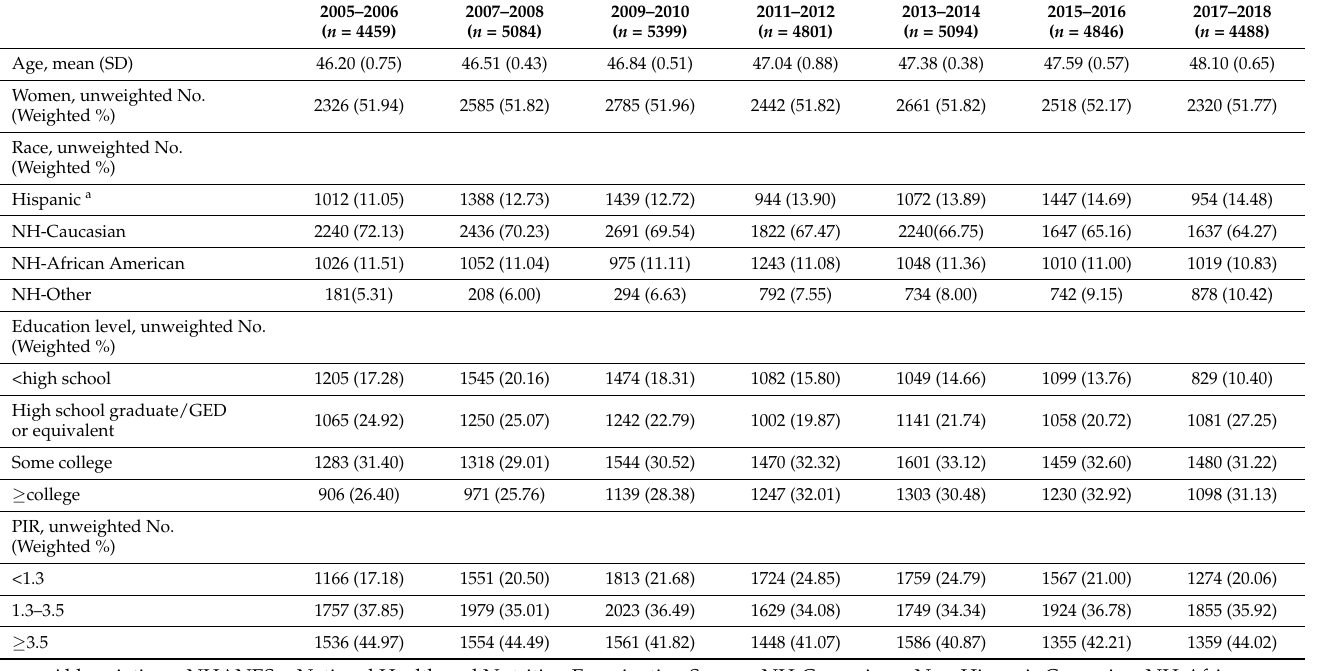
Table 1. Weighted characteristics of participants in seven National Health and Nutrition Examination Surveys from 2005 to 2018.